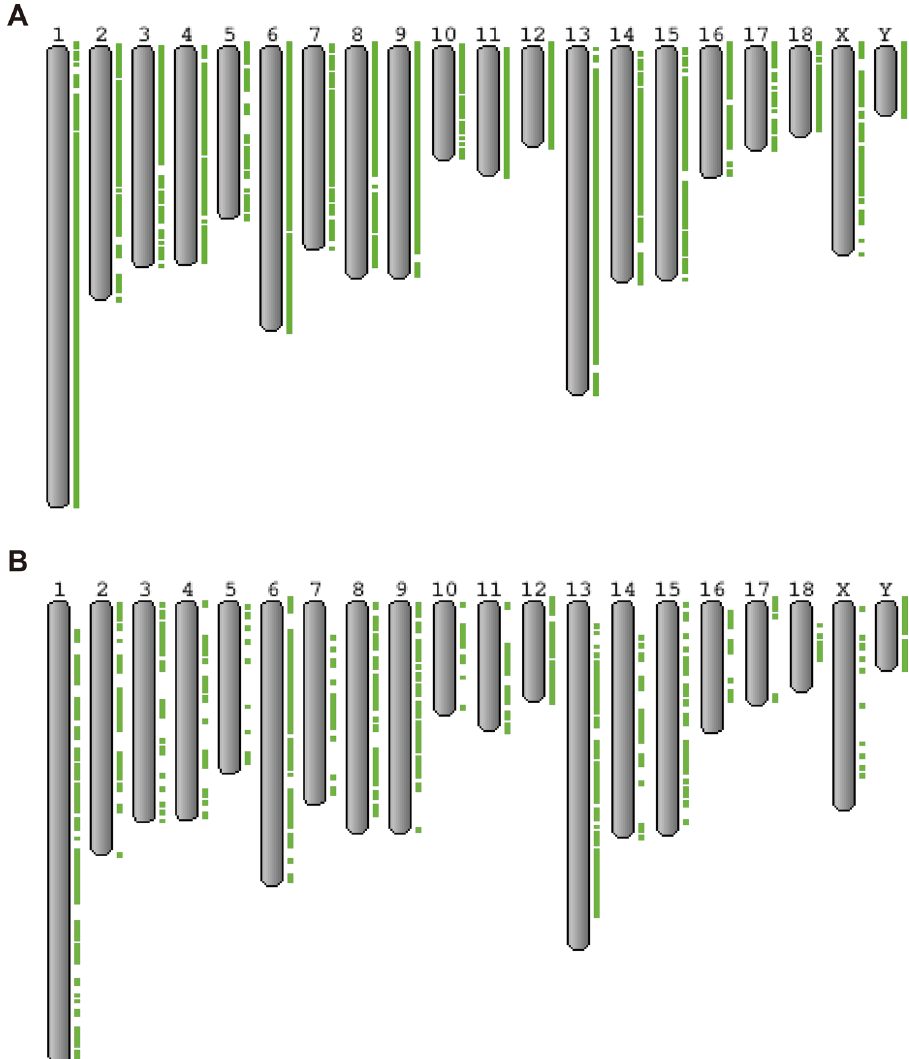
Figure 1. CNVR distribution. Distribution of CNVRs larger than 100 kb ( A ) and 500 kb ( B ) were visualized separately. Green rectangles on the right side of chromosomes represents